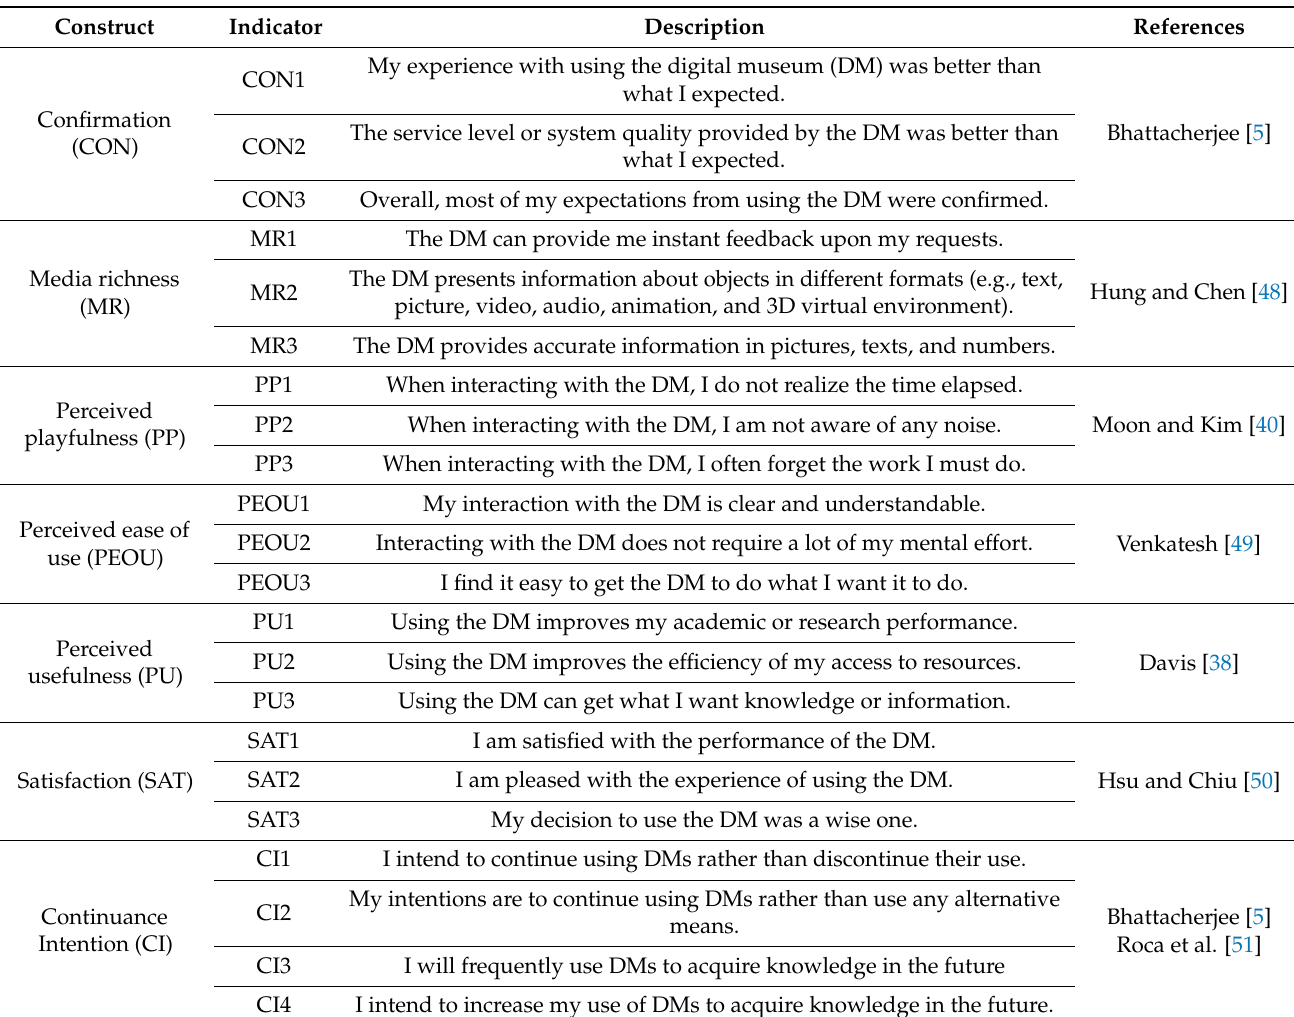
Table A1. Measurement Model and